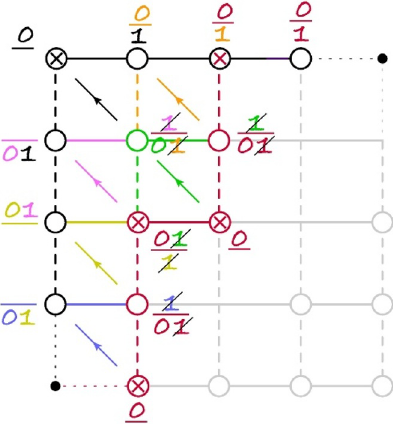
Figure 8 . From fermion to Beast: red to green to orange to blue to jade to purple to black. the field strength. The Bethe ansatz for this spin chain is obtained by restricting to the momentum-carrying bosonic node in figure 6(c). The overlap with the D3-D5 state is pro- portional to 1 /Q (0) Q ( i/ 2) , in agreement with the direct inspection of the spin chain, where the boundary state is the Néel-type SU(2) singlet